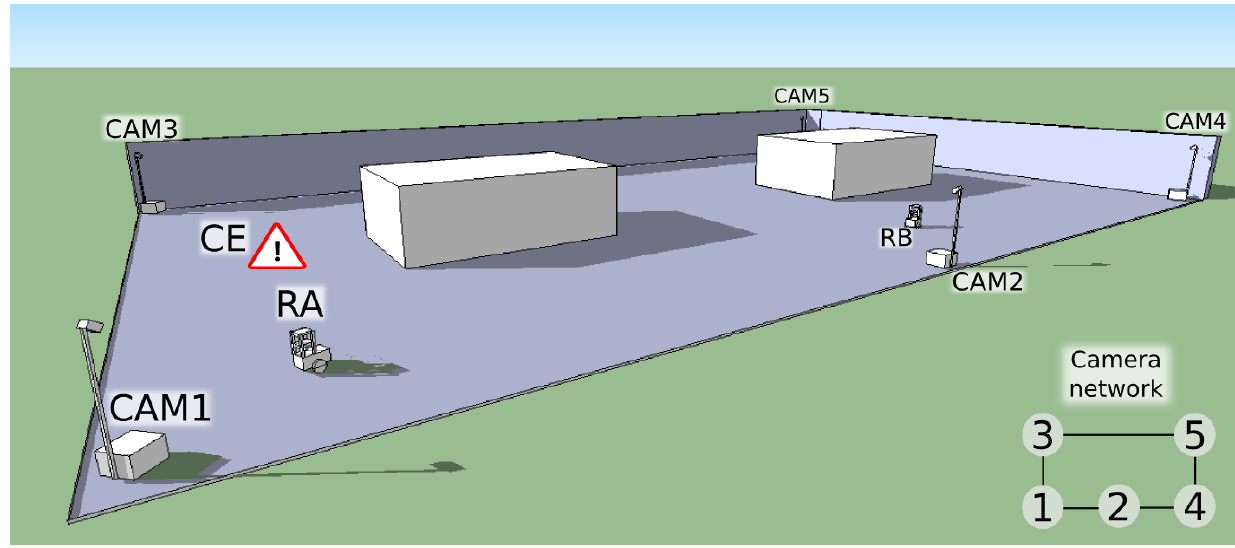
Figure 1. Example of the deployment of the multi-agent system: Camera-agent 3 (CAM3) is detecting a Call Event, while robot-agent A (RA) is being sighted by camera-agent 1 (CAM1) and robot-agent B (RB) by camera 2